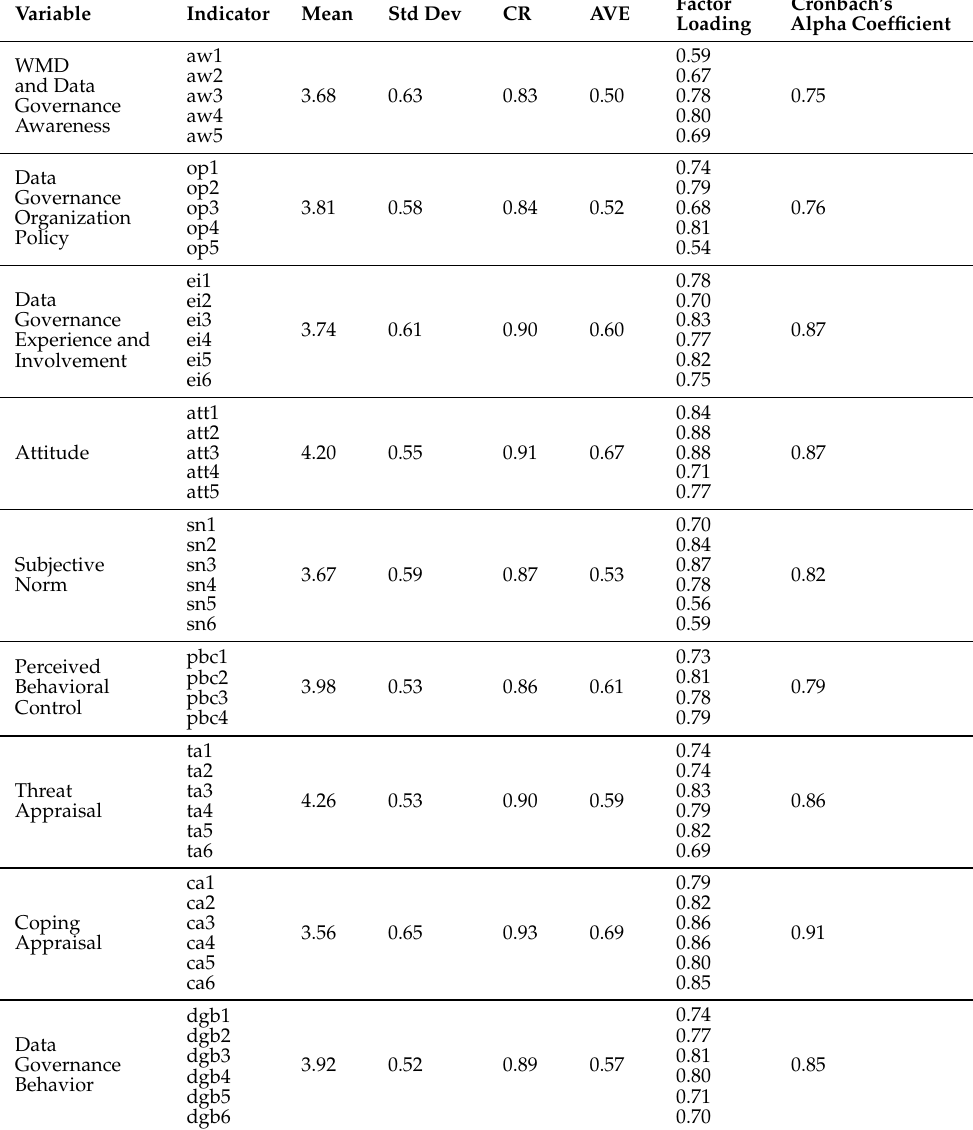
Table 3. The descriptive statistics and validity and reliability test results of the measurement model.